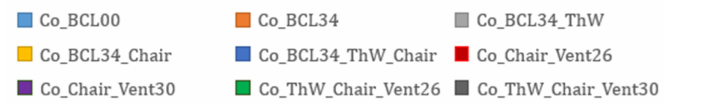
Figure 17. Summer (15.05 – 15.10): ( a ) Overall comfort values for the different controllers (n = 14688), ( b ) Thermal Hheating and cooling demand [kWhth/m²], ( c ) Used electrical end energy for heating and cooling with consideration of a reversible heat pump (COPHeating = 3, COPCooling = 2) and used energy for the decentralized systems [kWhel], ( d ) Electrical Eenergy of the decentralized systems, thermoelectric wall (ThW), chair (Ch), fan (V)